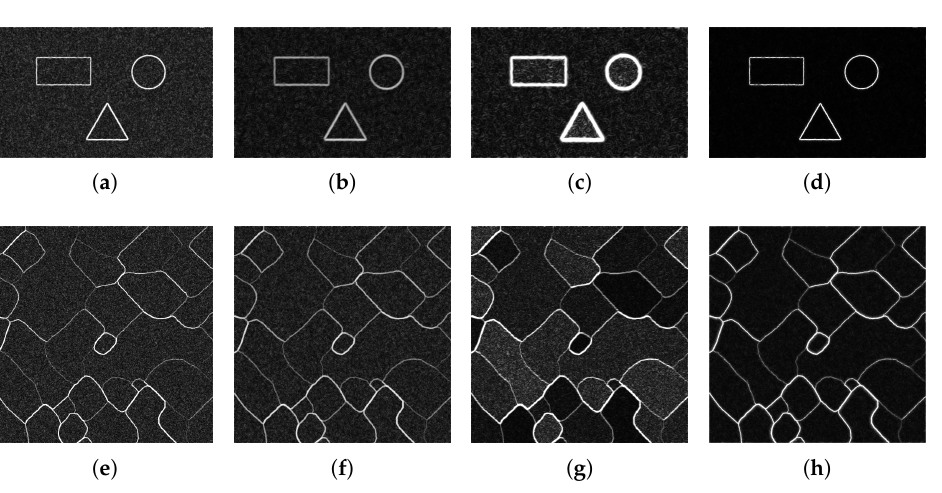
Figure 12. Edge strength maps obtained by ROEWA, RBED, UDR, and MSG on the one-look simu- lated SAR images: ( a , e ) ROEWA; ( b , f ) RBED; ( c , g ) UDR; ( d , h )